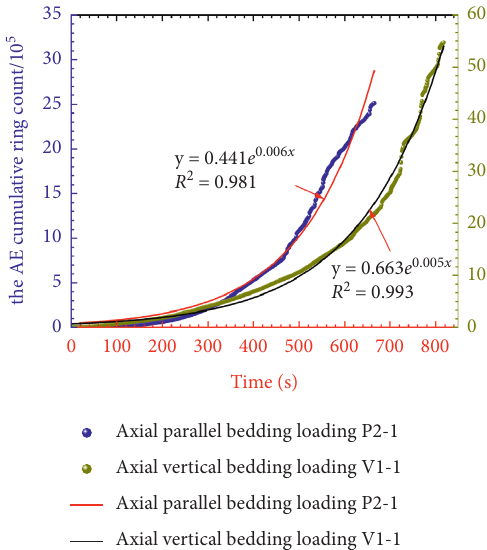
Figure 7: Relationship between cumulative ringing count and time of raw coal samples under different loading